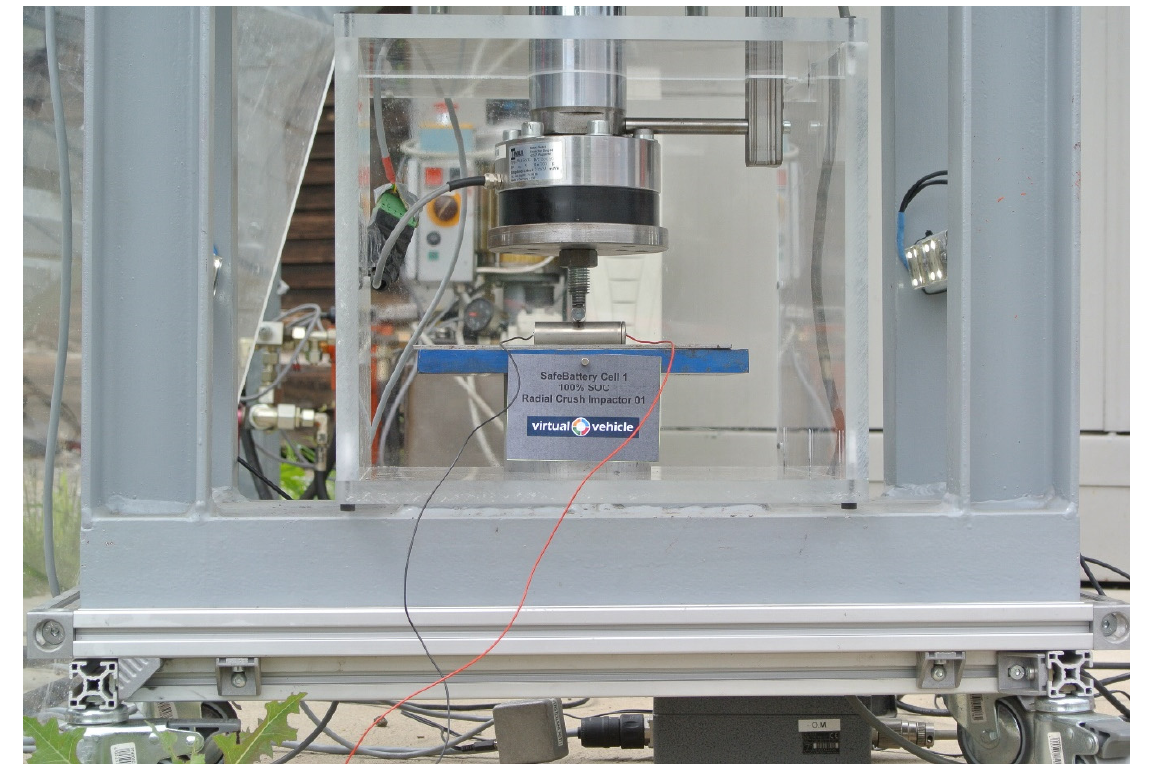
Figure 4. Hydraulic test bench.